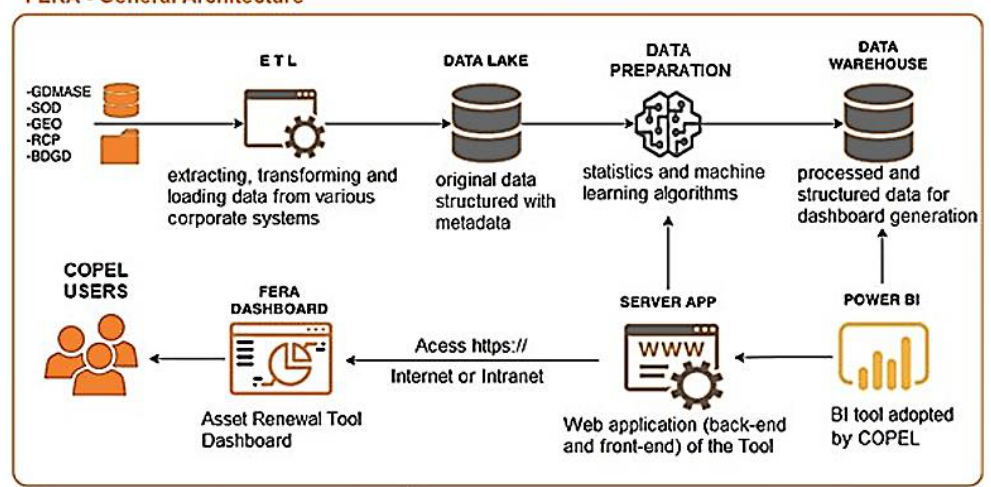
Figure 18. Overview of the architecture of the FERA [authors].